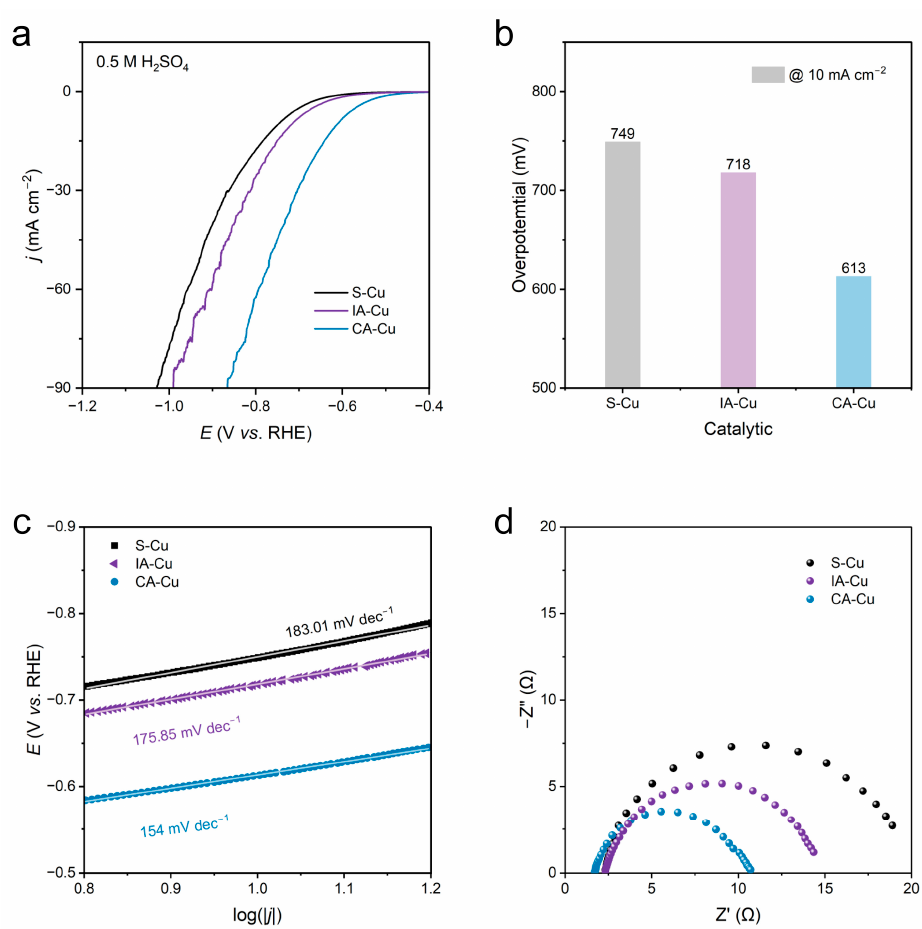
Figure 2. HER performance of samples S-Cu, IA-Cu, and CA-Cu. ( a ) LSV curves, ( b ) overpotentials at 10 mA cm − 2 , ( c ) Tafel curves, ( d ) Nyquist plots.